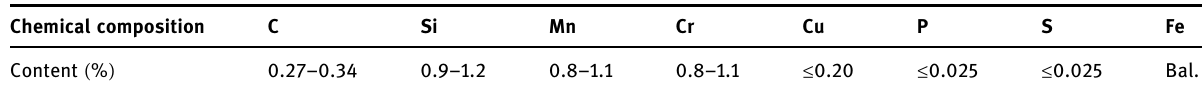
Chemical composition